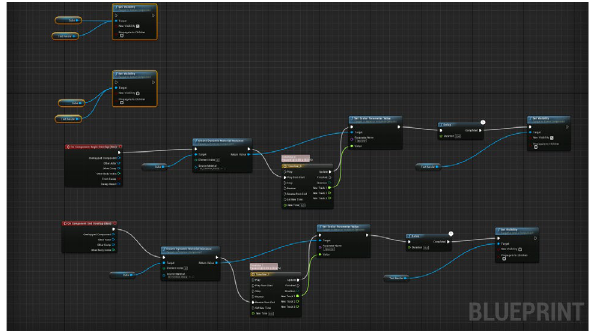
Figure 9. Blueprint Class of the info panel